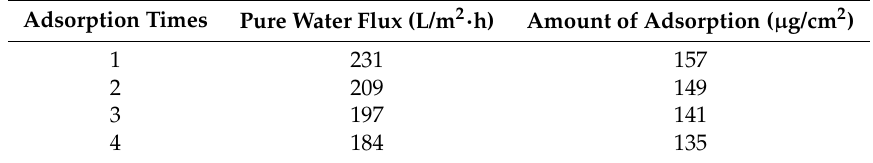
Table 1. The adsorption/desorption of polyvinylidene fluoride (PVDF) modified membrane and pure water flux.